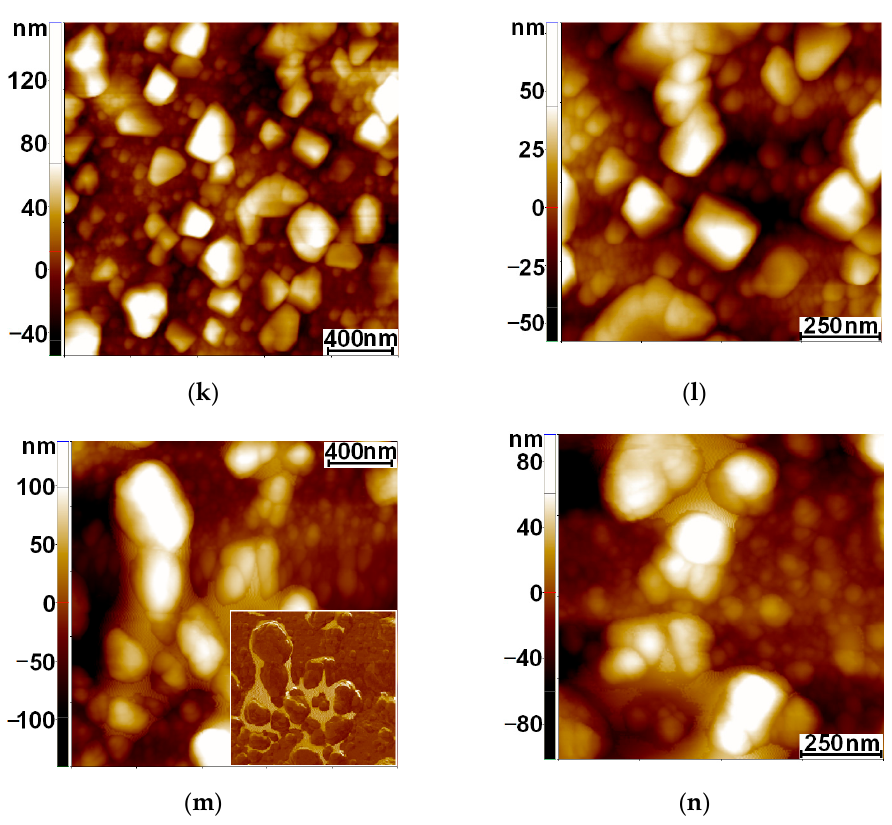
Figure 3. 2D AFM images at a scale of 2 × 2 µm 2 ( left column) and 1 × 1 µm 2 ( right column) for bare Ti foil ( a , b ), TiO 2 /Ti ( c , d ), Lys/TiO 2 ( e , f ), Au-modified TiO 2 ( g , h ), Lys/Au–TiO 2 /Ti ( i , j ), Ag-modified TiO 2 ( k , l ) and Lys/Ag-modified TiO 2 films ( m , n ). Phase contrast 2D AFM images are superimposed for Lys/Au/TiO 2 /Ti in ( i ) and for Lys/Ag/TiO 2 /Ti in ( m ).